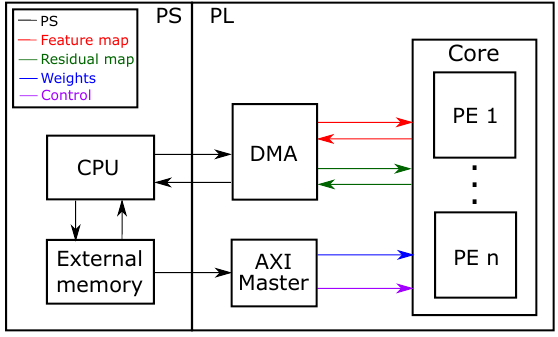
Figure 5. Architecture of the MobileNet V2 accelerator.